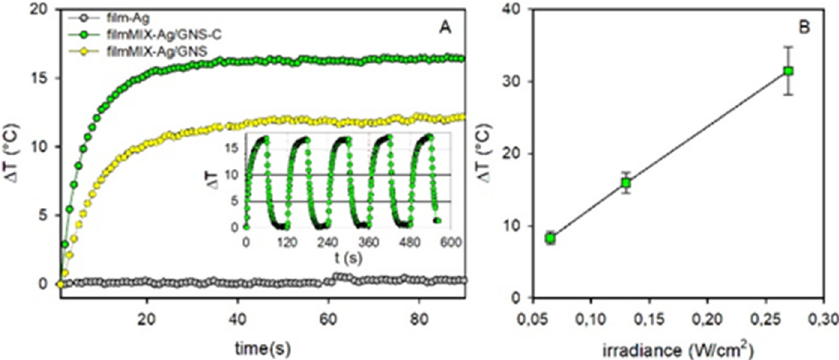
Figure 7. ( A ) Thermograms ( Δ T vs. time), irradiance 0.13 W/cm 2 ; inset: thermogram for filmMIX- Ag/GNS-C on alternating 60 s irradiation ON with 60 s OFF. ( B ) Δ T vs. irradiance for filmMIX- Ag/GNS-C showing a linear dependence.